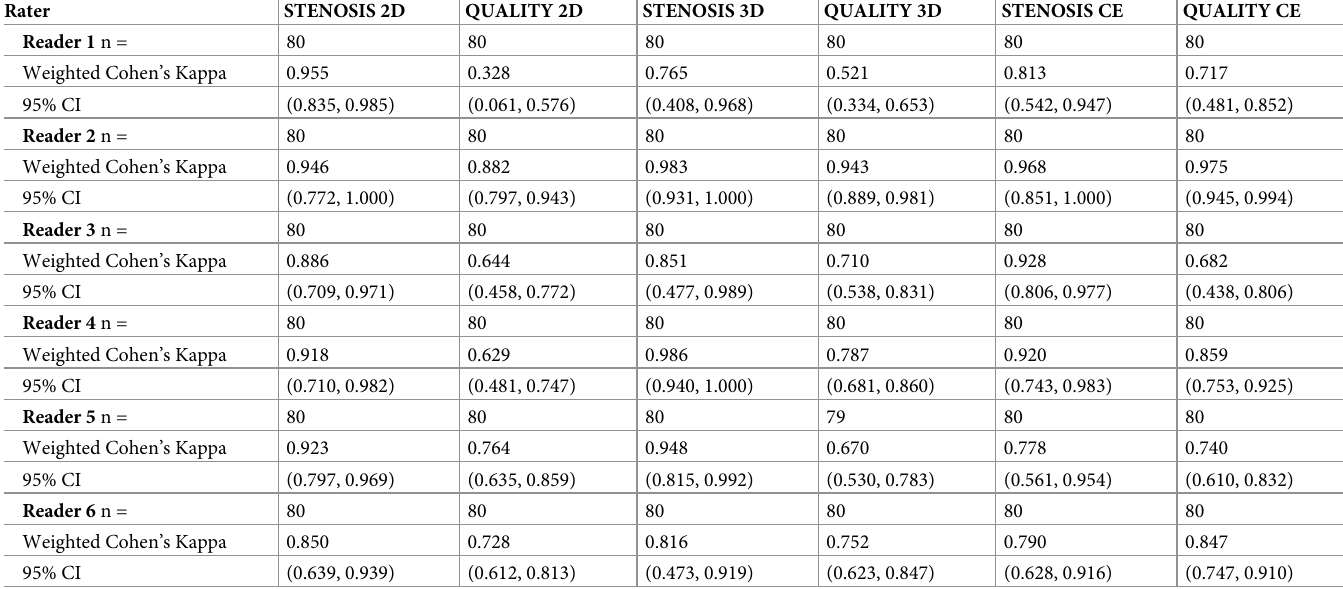
Table 2. Intra-rater reliability.